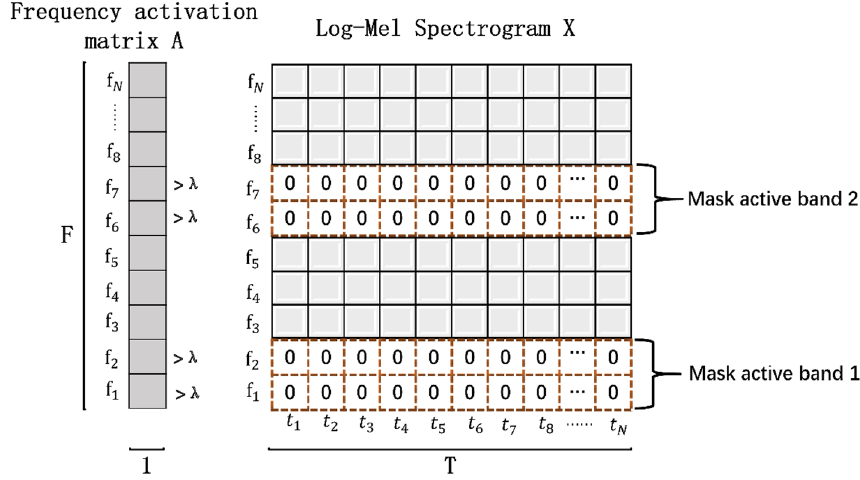
Figure 2. Mask the two active frequency bands of length 2 in the Log-Mel